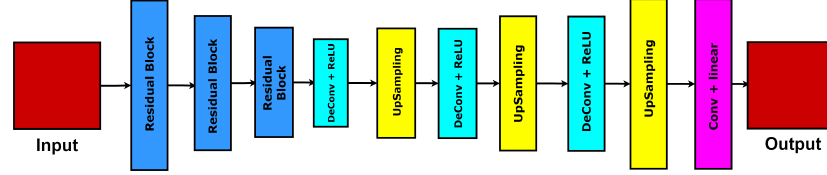
Figure 2. Proposed Residual Variational Autoencoder